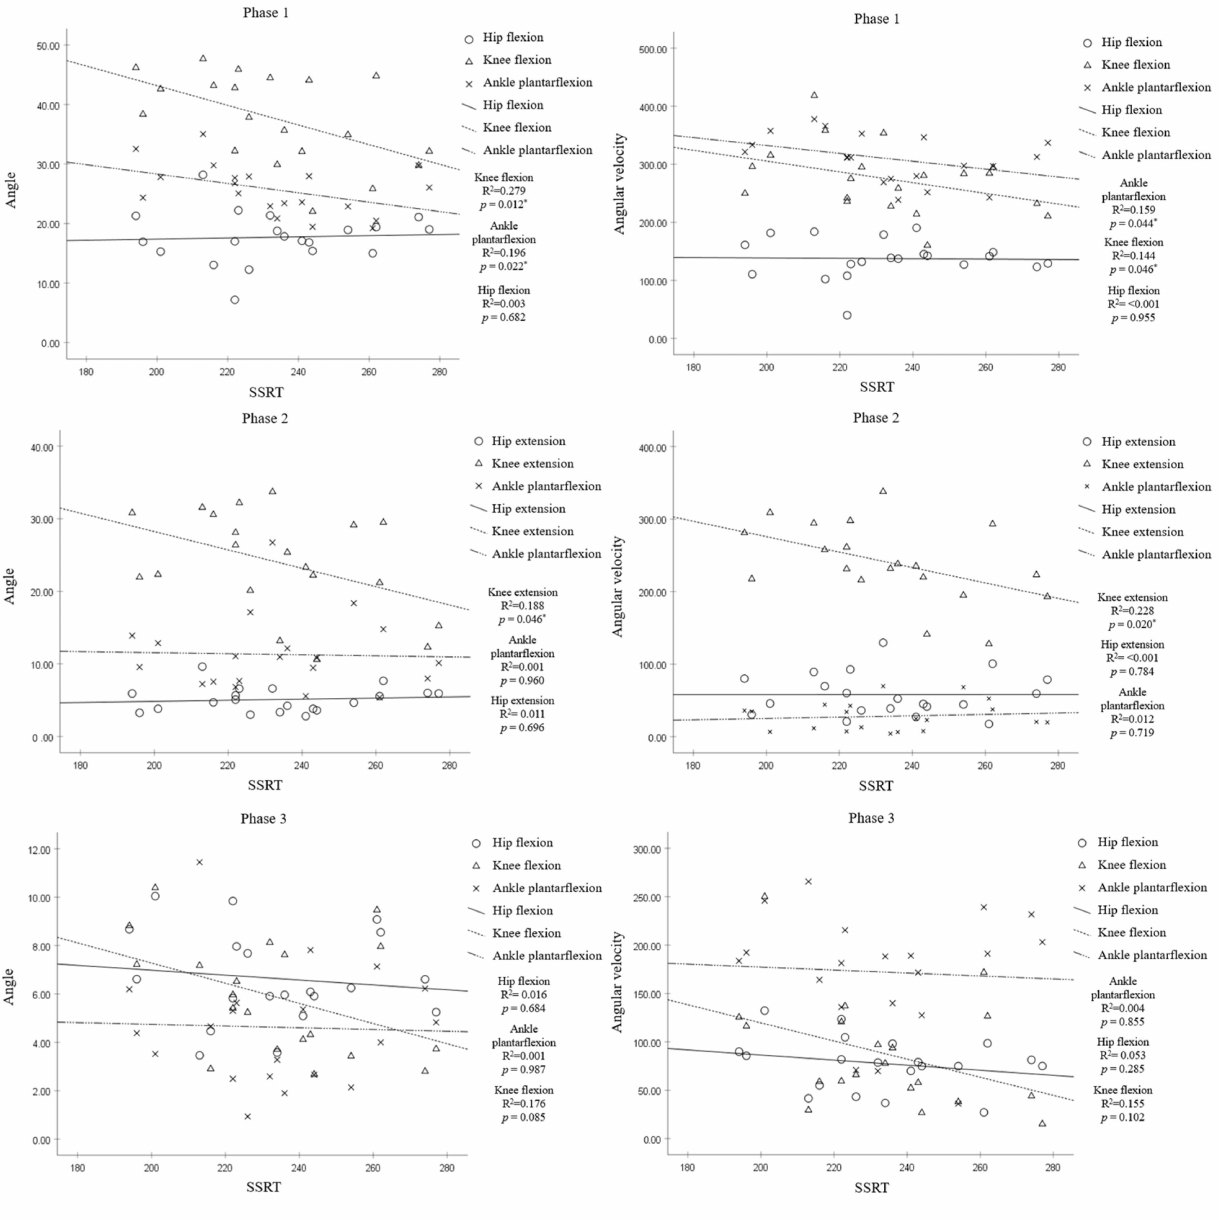
Figure 2. Correlation between SSRT and joint angle and joint angular velocity in all phases. * Signifi- cant correlation between SSRT and joint angle or joint angular velocity ( p <